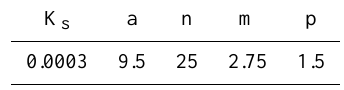
Table 2. Case study, permeability parameters.